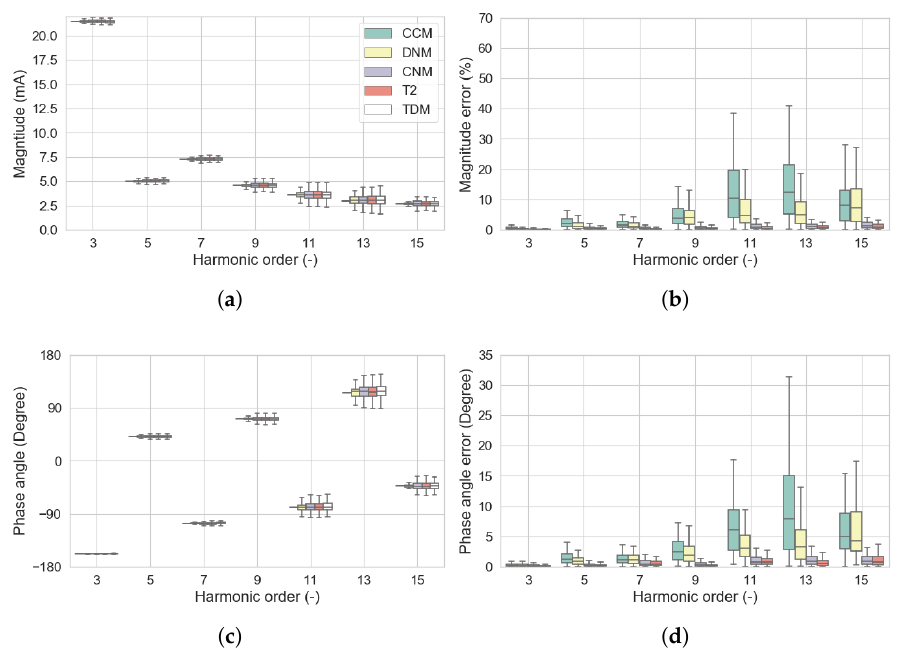
Figure 12. Comparison of the Type B LED lamp frequency domain models for flat-top voltage supply: ( a ) Magnitude; ( b ) Magnitude error; ( c ) Phase angle; and ( d ) Phase angle error.